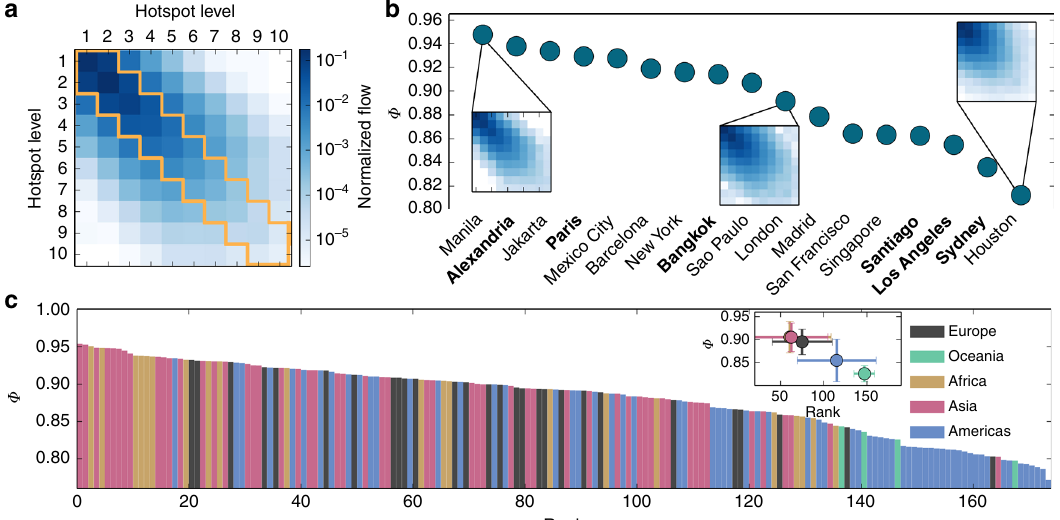
Fig. 2 City fl ow-hierarchy Φ calculation and ranking. a Matrix of trip fl ows T ij between hotspot of different levels for New York City (only fi rst ten levels are shown). Each entry of the matrix is normalized by the sum of all fl ows. The fl ow-hierarchy Φ is calculated by summing the tri-diagonal entries marked in yellow. b City fl ow-hierarchy for a subset of ordered cities and the corresponding trip-matrix for three examples: Manila (Philippines), London (UK) and Houston (USA). The cities marked in bold correspond to those shown earlier in Fig. 1c – h indicating a more spatially dispersed layout of the hotspots with decreasing Φ . c Full set of global cities ranked according to decreasing values of Φ and colored according to continent. The inset shows the mean and standard deviations for each continent for both Φ and the corresponding